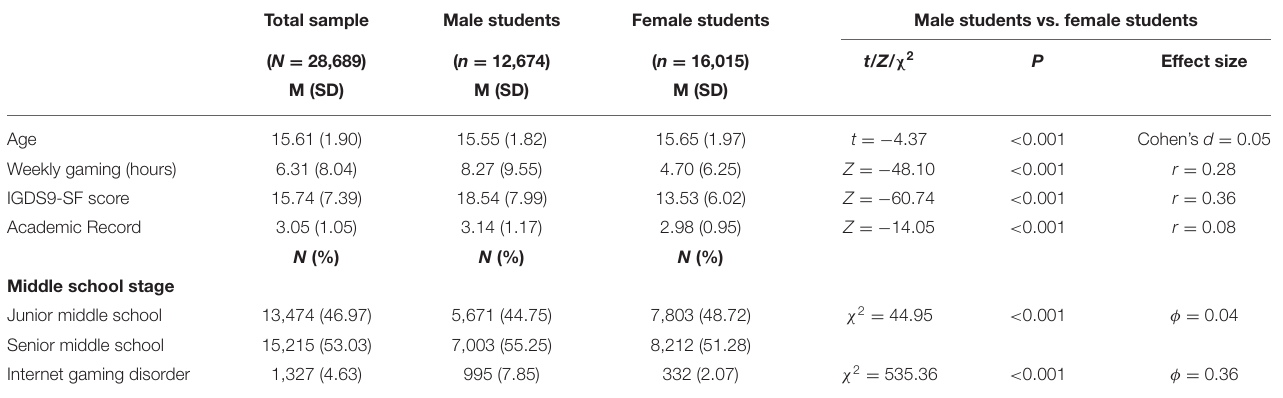
TABLE 1 | Sample characteristics and game-play-related behaviours ( n = 28,689).